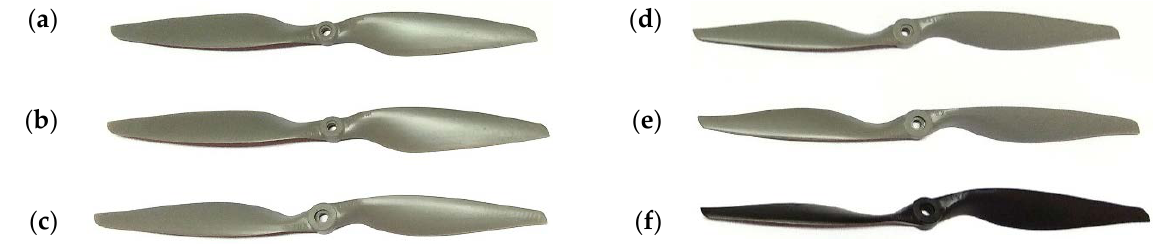
Figure 7. Summary of the tested propellers with different pitches: ( a ) 4.5″, ( b ) 5.5″, ( c ) 6″, ( d ) 8″, ( e ) 10 ″, and ( f ) 12″ .